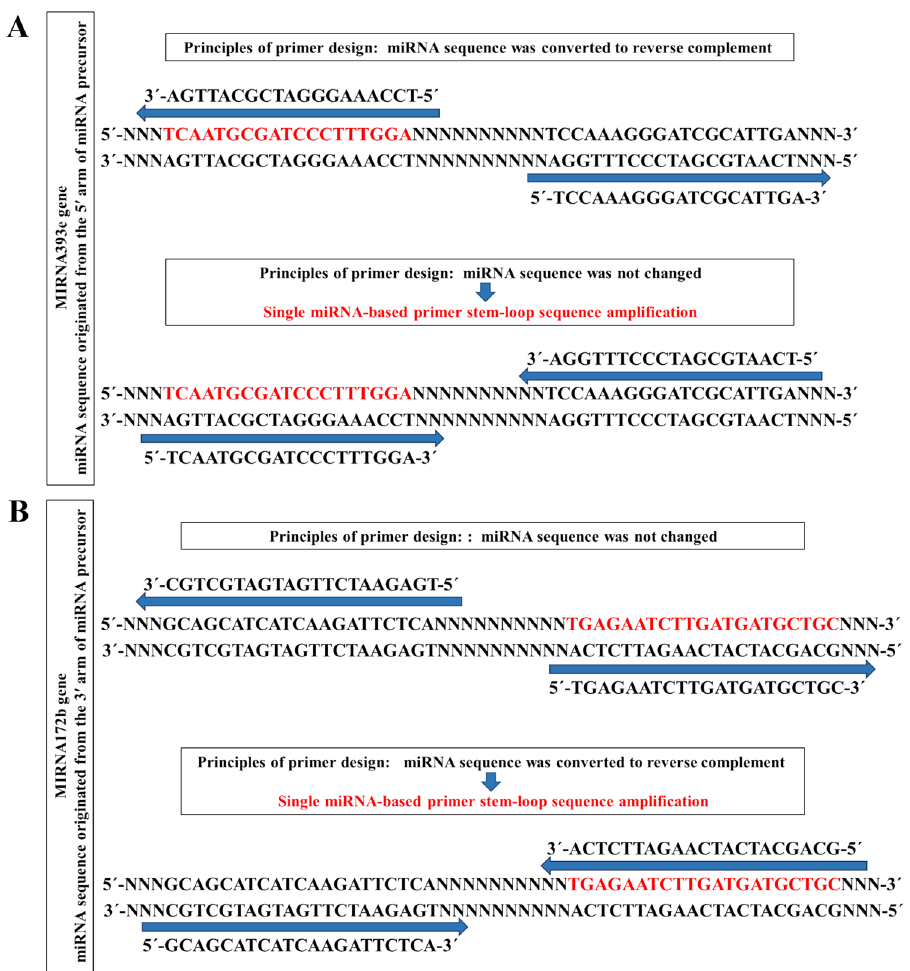
Figure 1. Primer design strategies for miRNA-based markers. ( A ) Mature miRNA originated from the 5 ′ arm of miRNA precursor was converted to reverse complement, ( B ) Mature miRNA originated from the 3 ′ arm of miRNA precursor was not changed. The blue arrow indicates the primer